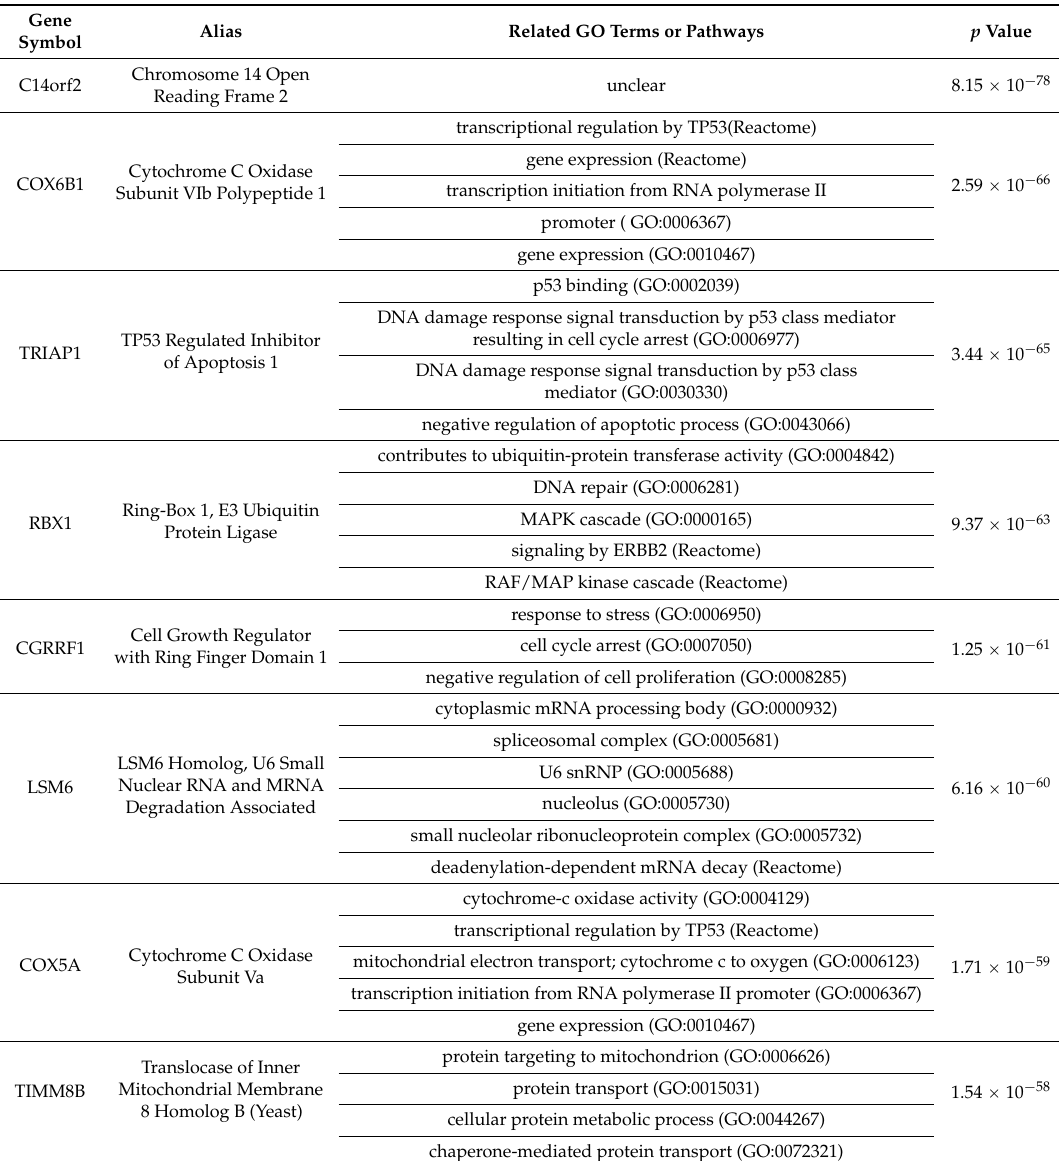
Table 6. Top 10 up-regulated differentially expressed genes for serous